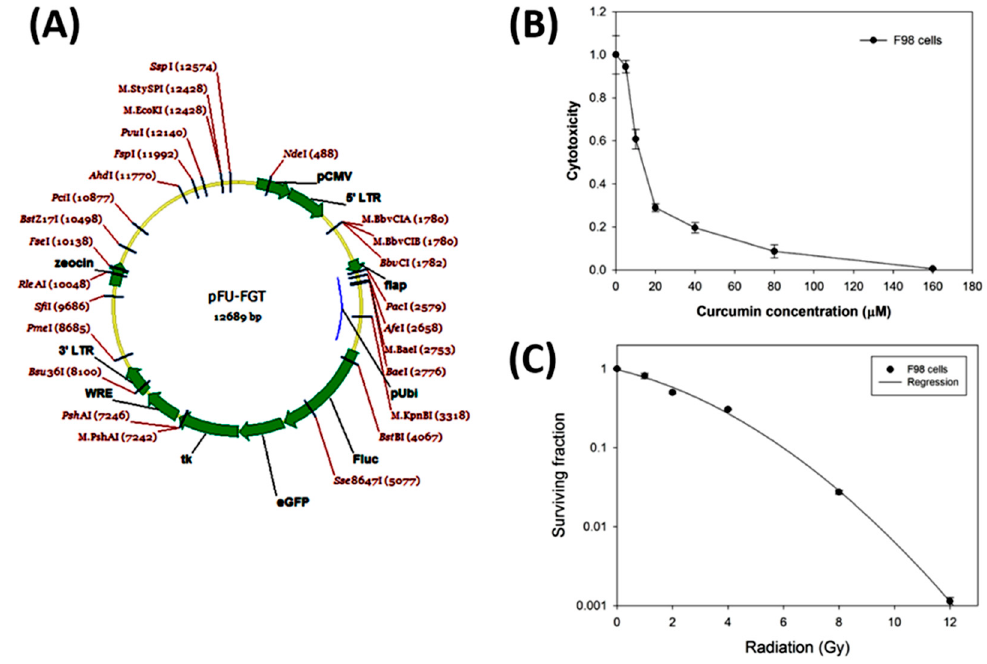
Figure 1. Lentiviral-based trifusion reporter vector, cytotoxicity of curcumin on F98 glioblastoma cells, and radiation survival curve of F98 glioblastoma cells. ( A ) The gene map of constructed lentiviral-based trifusion reporter vector. FGT : F stands for Fluc : firefly luciferase; G stands for eGFP : enhanced green fluorescent protein; T stands for tk : thymidine kinase. pUbi: ubiquitin promoter; LTR: long terminal repeat. ( B ) F98 cells were treated with various concentrations of curcumin (0–160 µ M) for 24 h and determined with MTT assay. IC 50 is about 15 μ M. ( C ) F98 cells were irradiated with 0–12 Gy of X-ray, and surviving fractions were assayed by colony formation. D 10 is about 6 Gy.